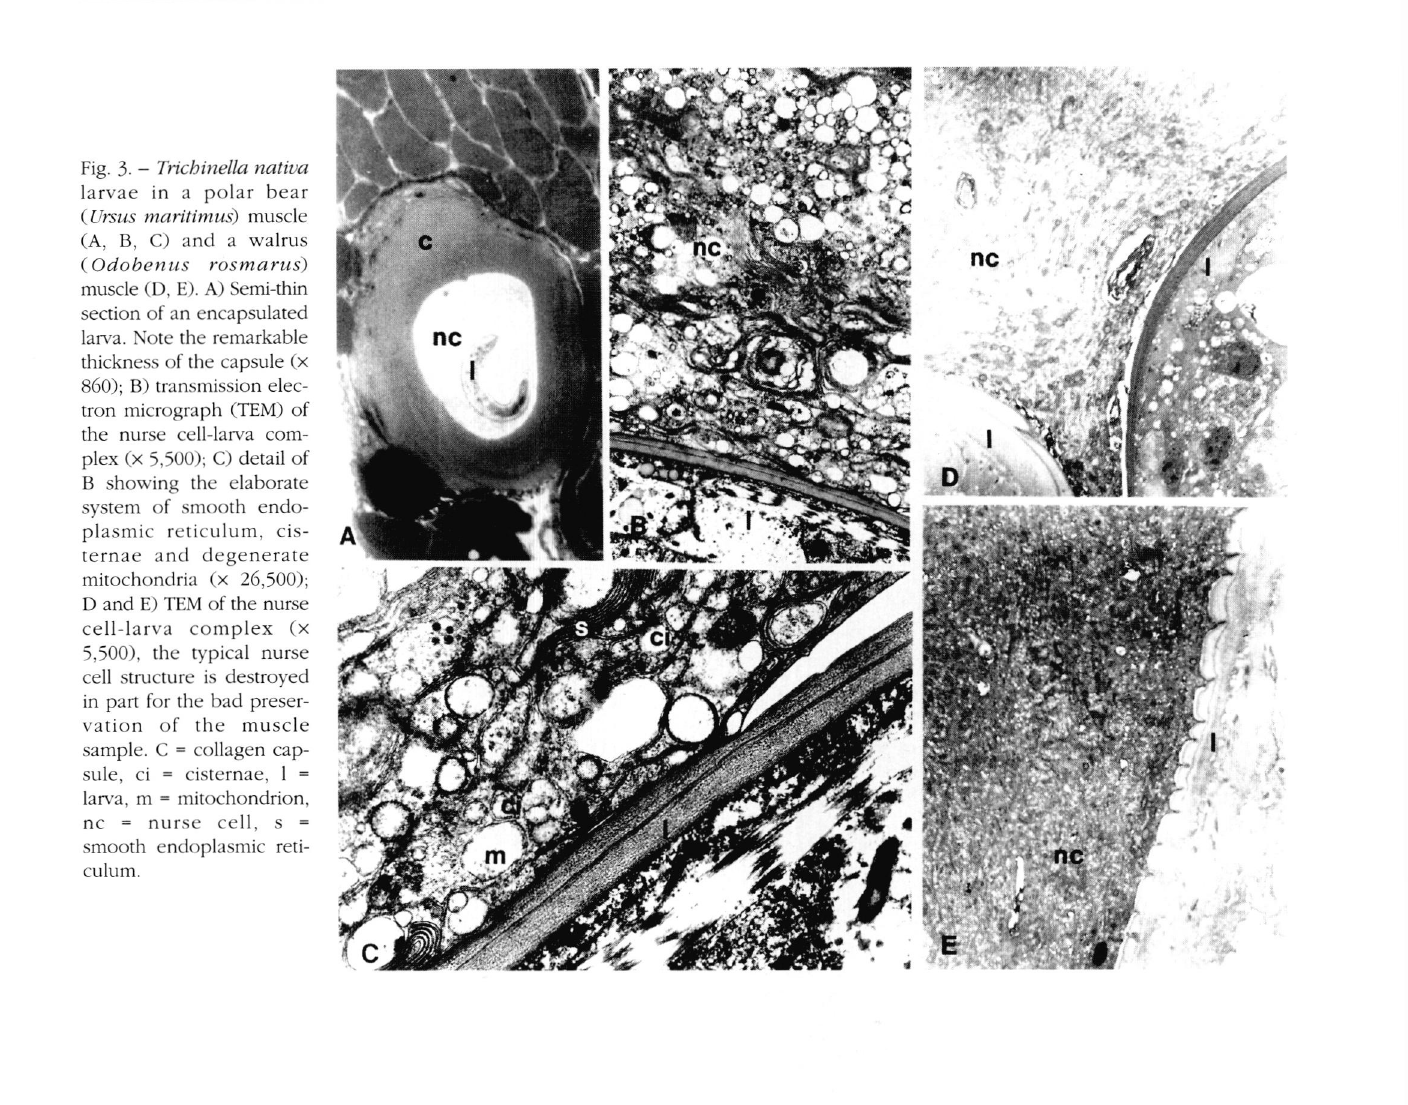
Fig. 3. - Trichinella nativa larvae in a polar bear muscle (A, B, C) and a walrus rosmarus ) muscle (D, E). A)